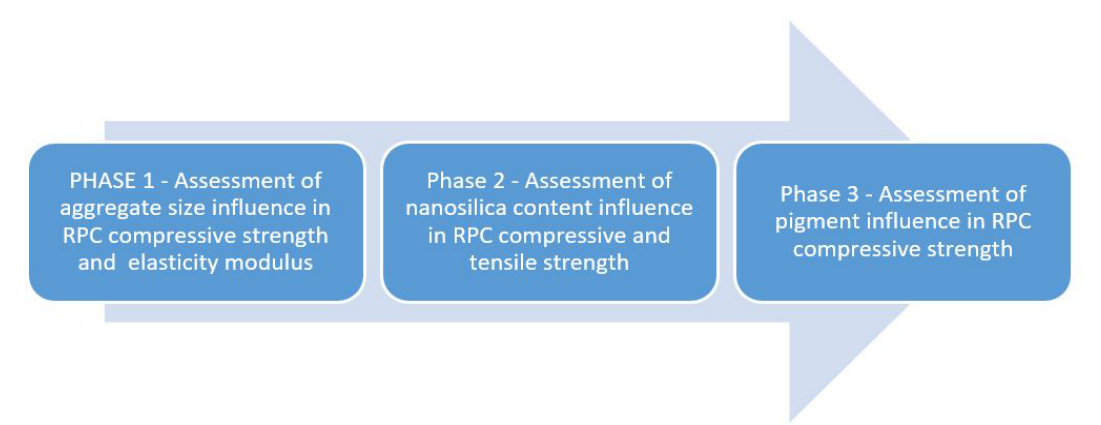
Figure 1. Research